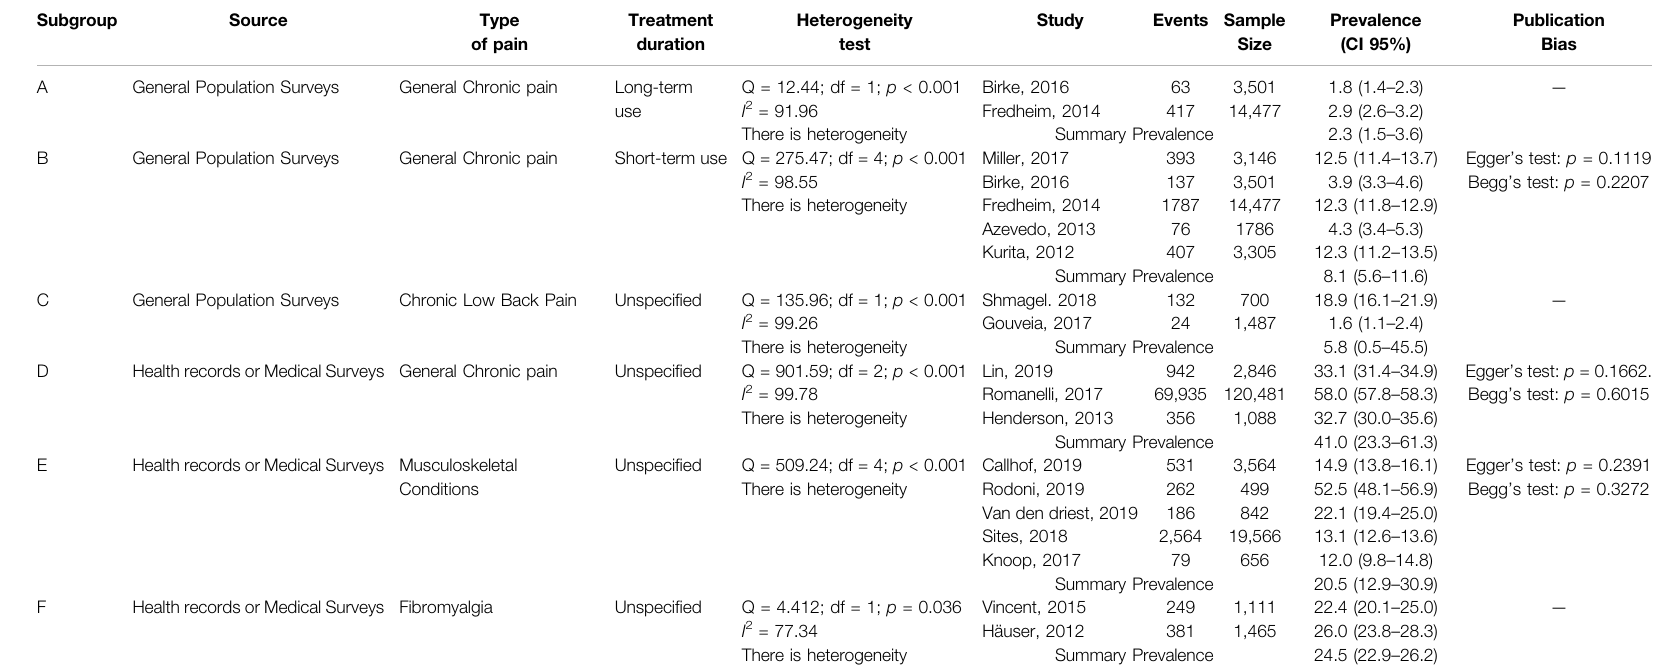
TABLE 3 | Characteristics of the subgroups and results of the meta-analysis.